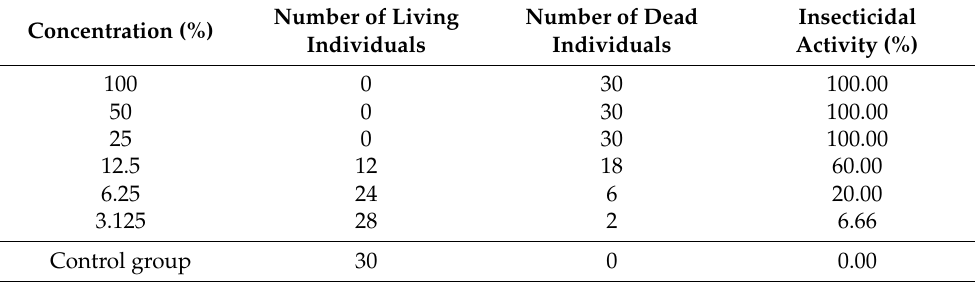
Table 7. Insecticidal activity of Eucalyptus globulus essential oil. Number of Living Number of Dead Concentration (%) Individuals Individuals